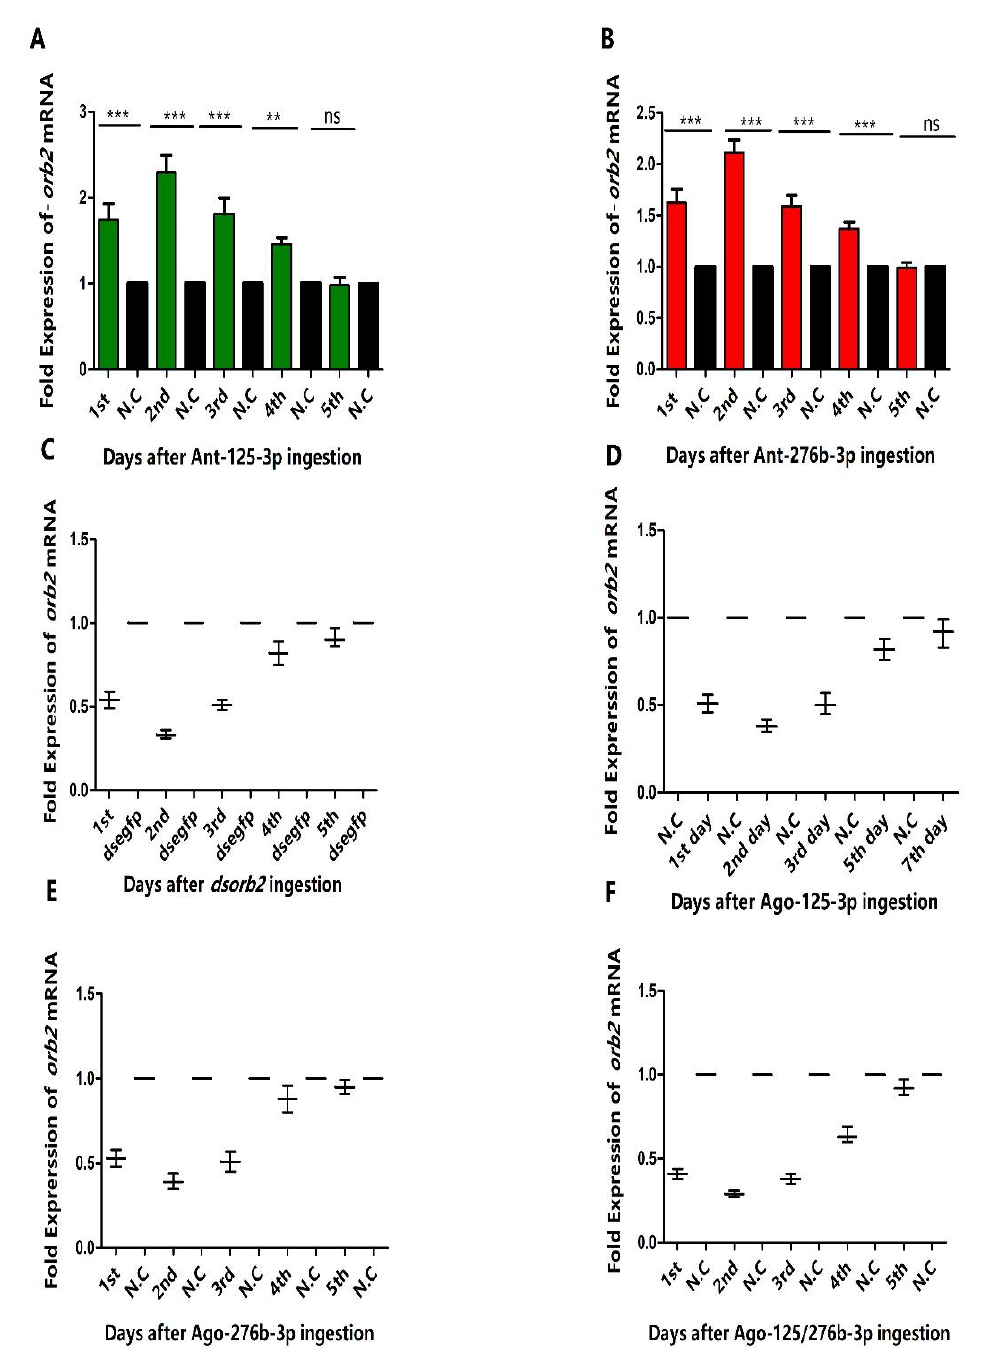
Figure 3. Effects of dsorb2 , agomirs, and antagomirs of miR-125-3p, miR-276b-3p on mRNA of orb2. ( A ) Fold expression of orb2 mRNA after ingestion of antagomir-125-3p. ( B ) Fold expression of orb2 mRNA after ingestion of antagomir-276b-3p. ( C ) Fold expression of orb2 mRNA after ingestion of dsorb2 . ( D ) Fold expression of orb2 mRNA after ingestion of agomir-125-3p. ( E ) Fold expression of orb2 mRNA after ingestion of agomir-276b-3p. ( F ) Fold expression of orb2 mRNA after ingestion of agomir-125/276b-3p combination. miR-125-3p and miR-276b-3p expression was normalized to U6 and orb2 mRNA was normalized to β actin. ” N.C ” represents negative control.